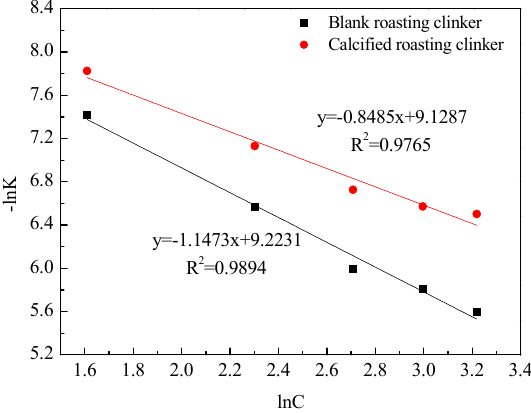
Figure 14. The fitting curve of roasted clinker lnC and − lnK.